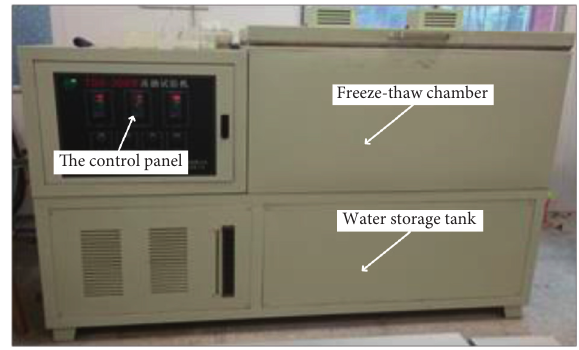
Figure 7: AniMR-150 NMR imaging system. Figure 8: TDS-300 F-T test Table 1. And the relationships between the brittleness and mechanical parameters and porosity are drawn in Figure 14.